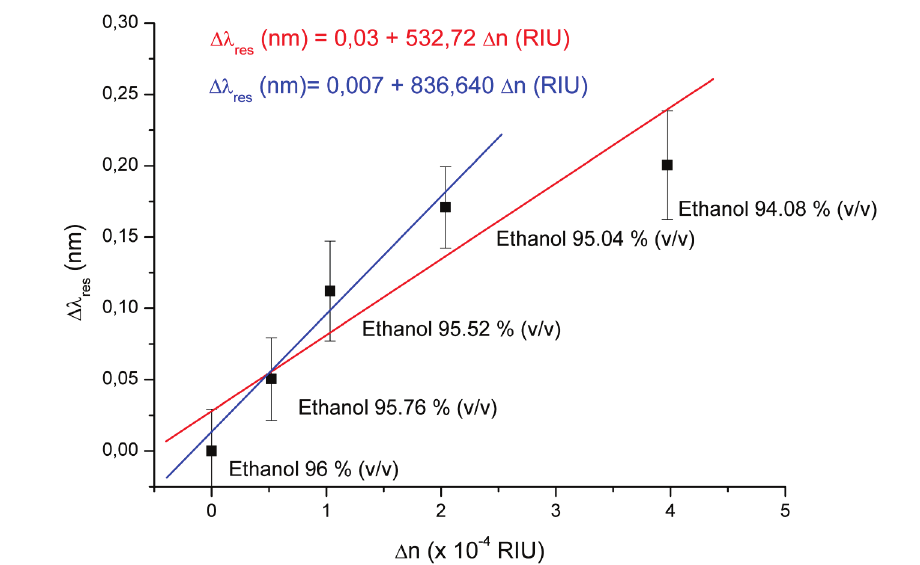
Figure 6. Shift of the resonant wavelength plotted as a function of refractive index shift (Δ n ). Linear fit of the experimental data yields Δ λ /Δ n Δ 532 nm/RIU (sensitivity) for a dynamic range of 4 × 10 –4 RIU (R 2 = 0.84). For a dynamic range of 2.1 × 10 –4 RIU, the linear fit of the experimental data yields a sensitivity of Δ λ /Δ n Δ 836 nm/RIU (R 2 = 0.97). The error bars refer to fluctuations on the resonant wavelength after successive injections with the same